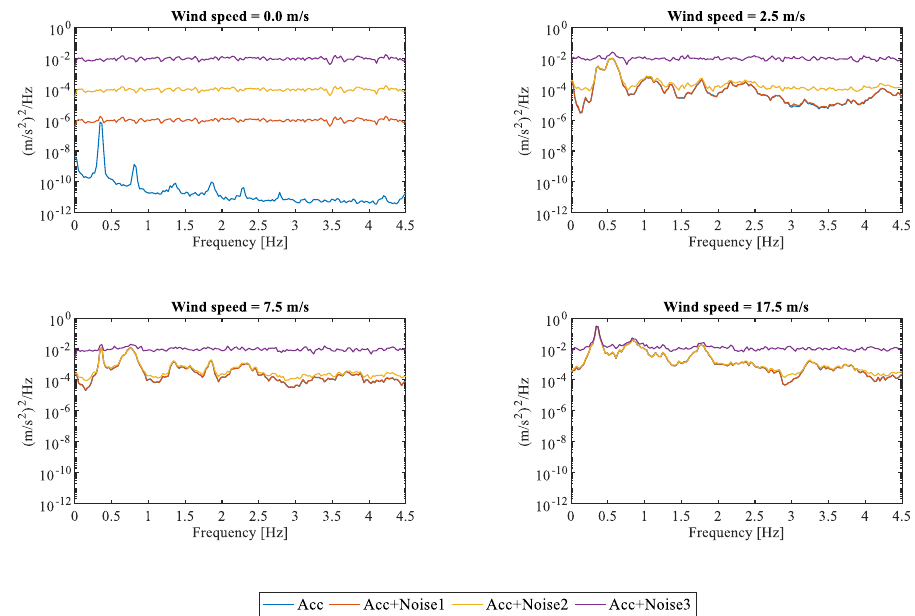
Figure 5. Power spectra of typical acceleration time series measured at the tower top for varying wind velocities: original signal (Acc) and original signal contaminated with different levels of noise (Acc+Noise1,2,3).